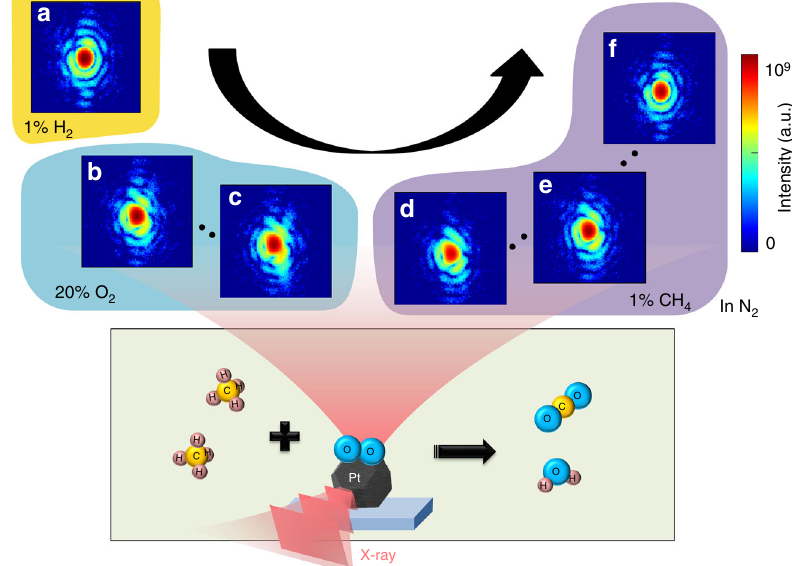
Fig. 1 Schematic of in situ Bragg coherent X-ray diffraction imaging (BCDI). The BCDI measurement scheme during methane catalytic oxidation illustrates the acquisition of (111) Bragg coherent diffraction patterns from the same Pt nanocrystal throughout. Slices through the Bragg coherent diffraction patterns are measured for Pt nanocrystals above the catalytic activation temperature in the presence of different gases. a After 36 min in H 2 , b 2.6 min, and c 36 min after the O 2 insertion, d ~2.6 min, e 16 min, and f 36 min after CH 4 was introduced. Under a 20% O 2 gas fl ow, the diffraction pattern becomes